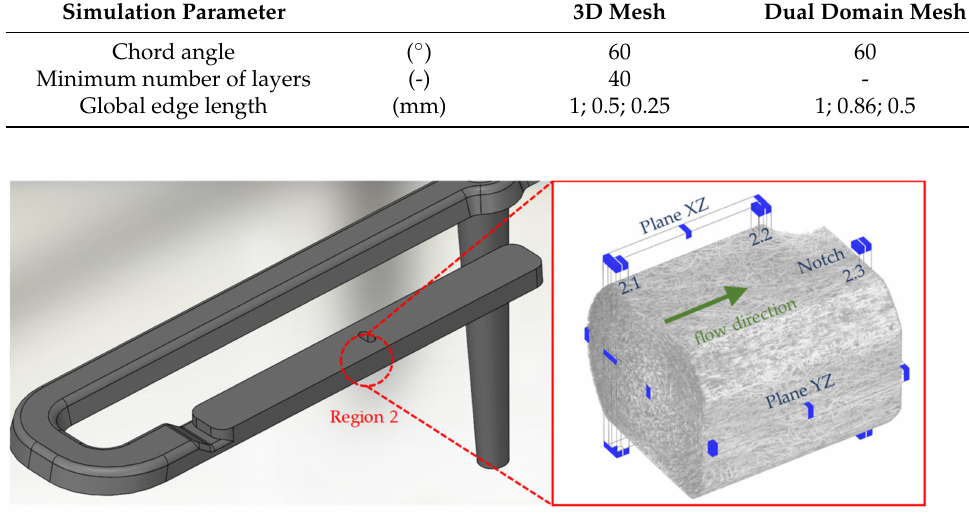
Figure 5. Region and planes investigated to evaluate the quality of the 3D